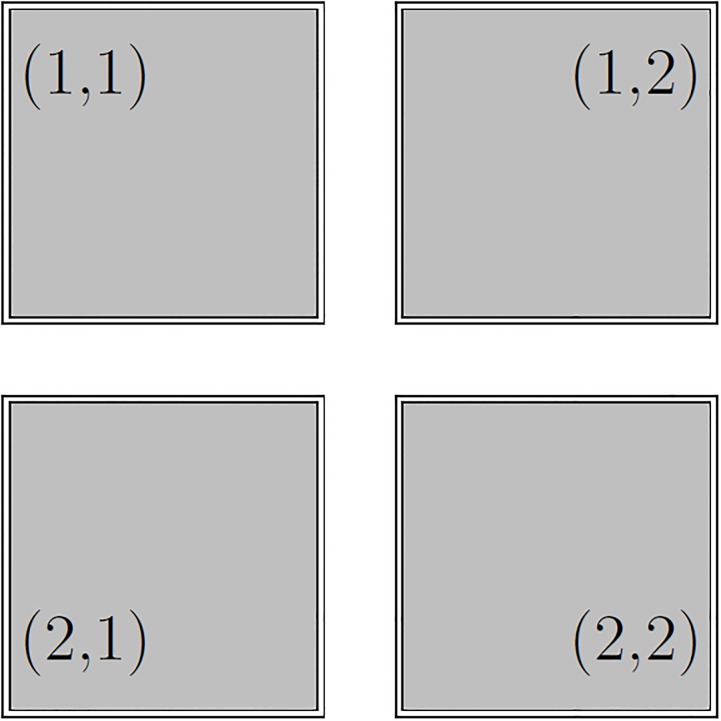
The 2 × 2 grid for multi-PTC with grid technique.